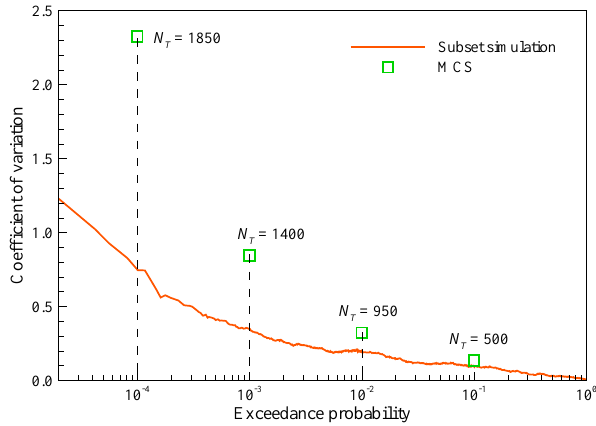
Figure 4. Comparison of the coefficient of variation of exceedance probability in subset simulation and direct MCS.